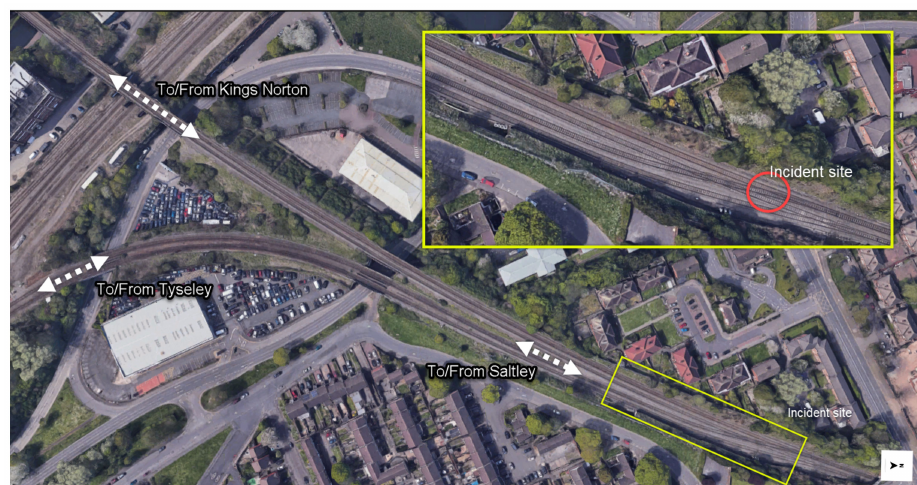
Figure 3. Details of the incident site and